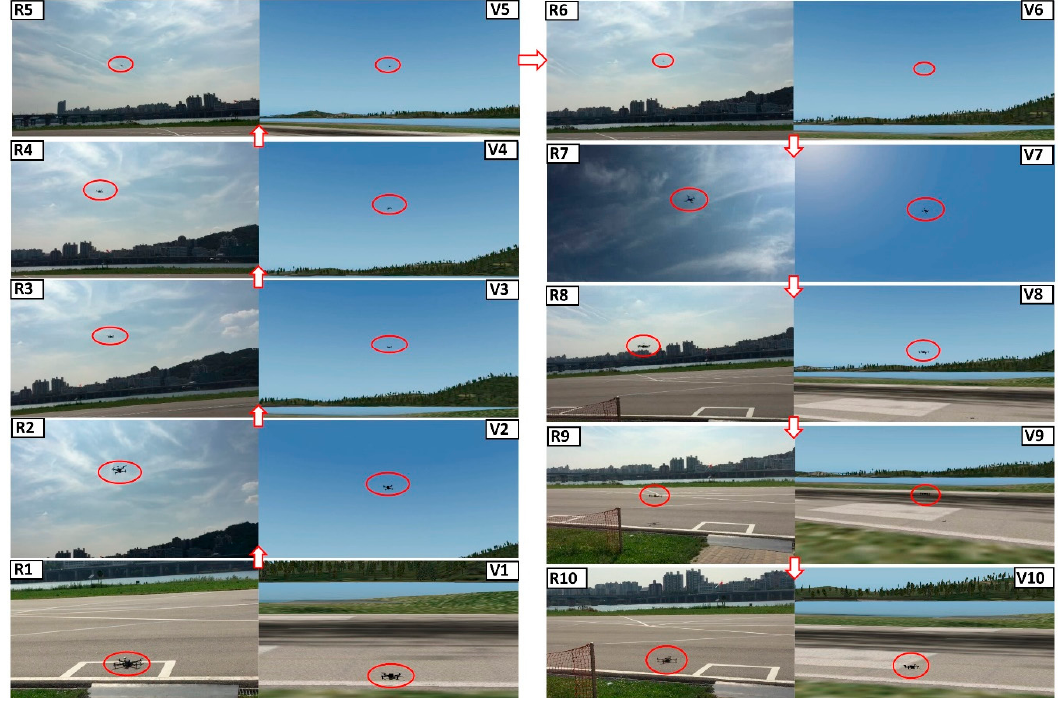
Figure 27. Mixed reality simulation of the quadcopter (R series = real part and V series = virtual part).